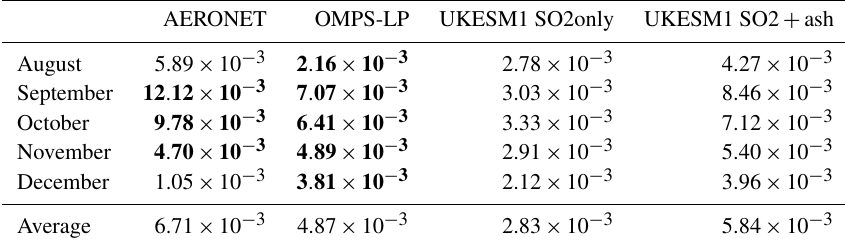
Table 3. Perturbation of AOD from the long-term mean retrieved from the Mauna Loa Observatory AERONET site scaled to 532nm. OMPS- LP, UKESM1 SO2only, and SO2 + ash sAOD perturbation calculated across an area encompassing the MLO (19–20 ◦ N, 152–156 ◦ W). Observations highlighted with bold text are statistically significantly greater than the long-term mean at 95% confidence level. Negative values of AOD are a result of calculating the perturbation from the long-term mean